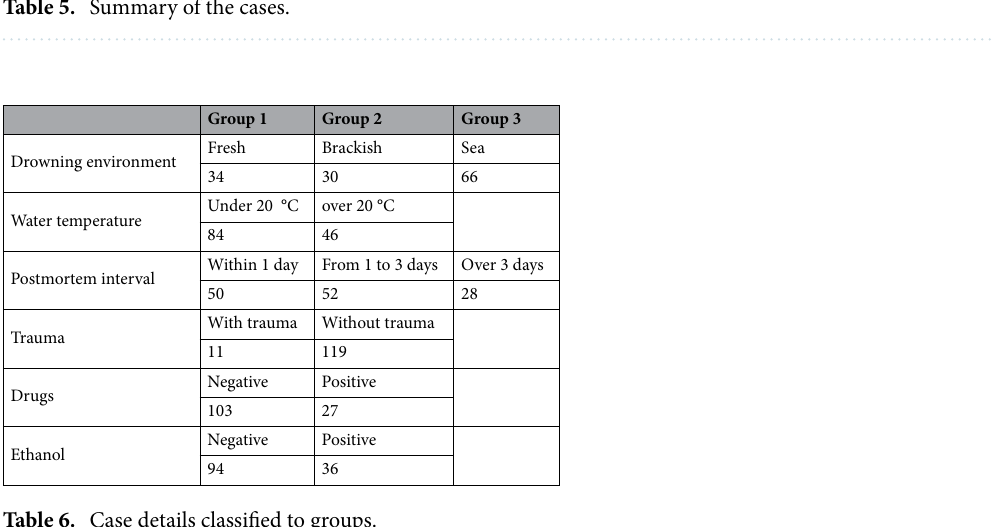
Table 6. Case details classified to